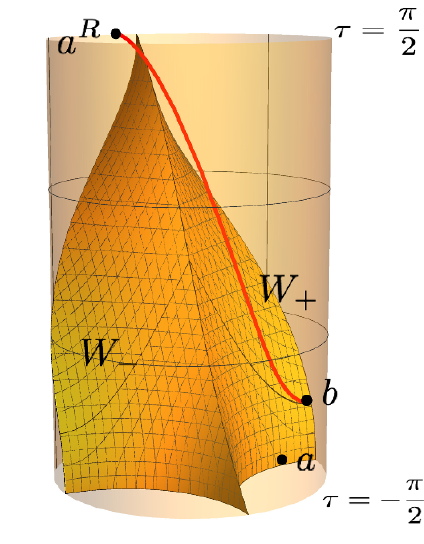
Figure 21 . A re(cid:13)ection geodesic in relation to the wedge of the infalling